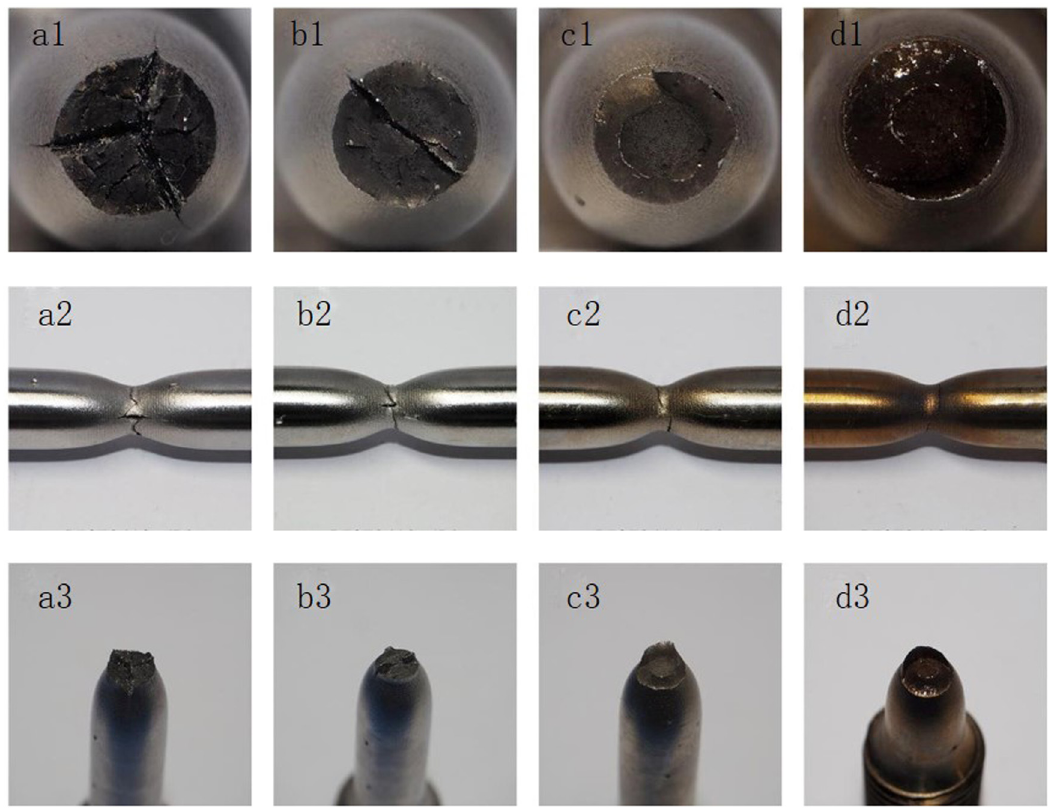
Figure 7: Macroscopic morphology of fracture of 1Cr13 after high - temperature tensile test: ( a ) 25°C, ( b ) 150°C, ( c ) 250°C, and ( d )